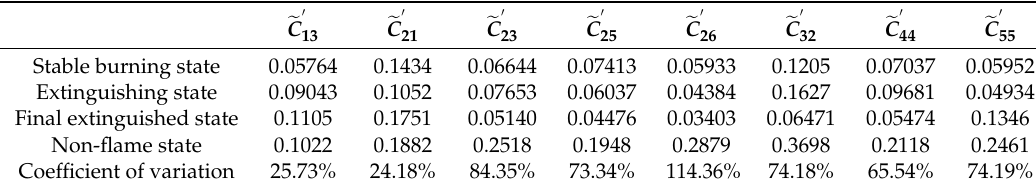
Table 1. Average values of the region moment invariants.